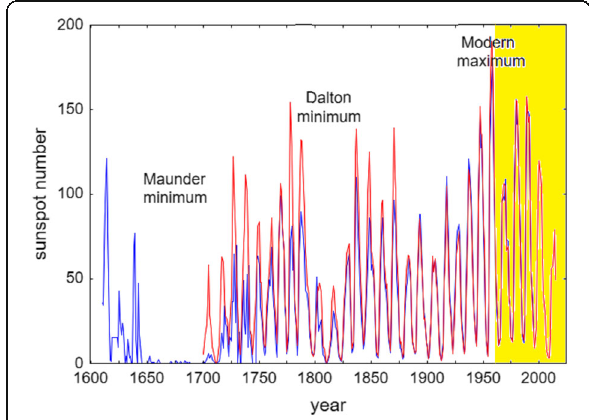
Fig. 1 Instrumental sunspot observations: group sunspot number (Hoyt and Schatten 1998) — blue line and international sunspot number (Clette et al. 2007) — red line. The shaded area indicates the “ space era ” which started with the launching of the first artificial satellites of the Earth for in situ measurements in the outer